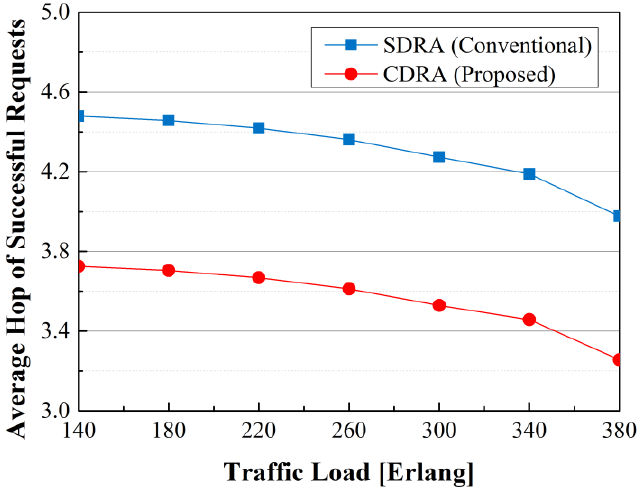
Figure 11. Performance comparison in terms of average hop of successful requests.